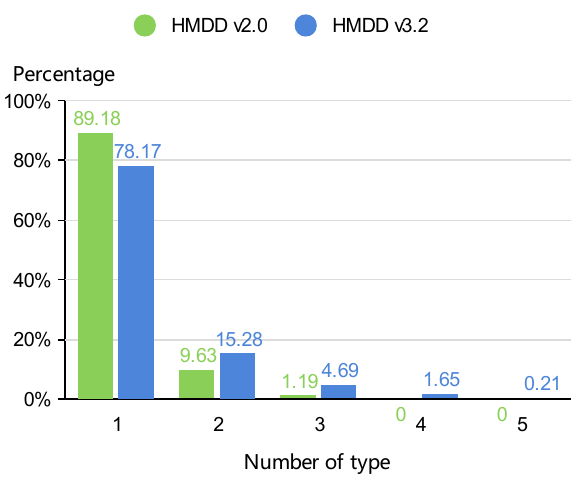
Figure 1. The percentages of miRNA-disease associations containing different numbers of